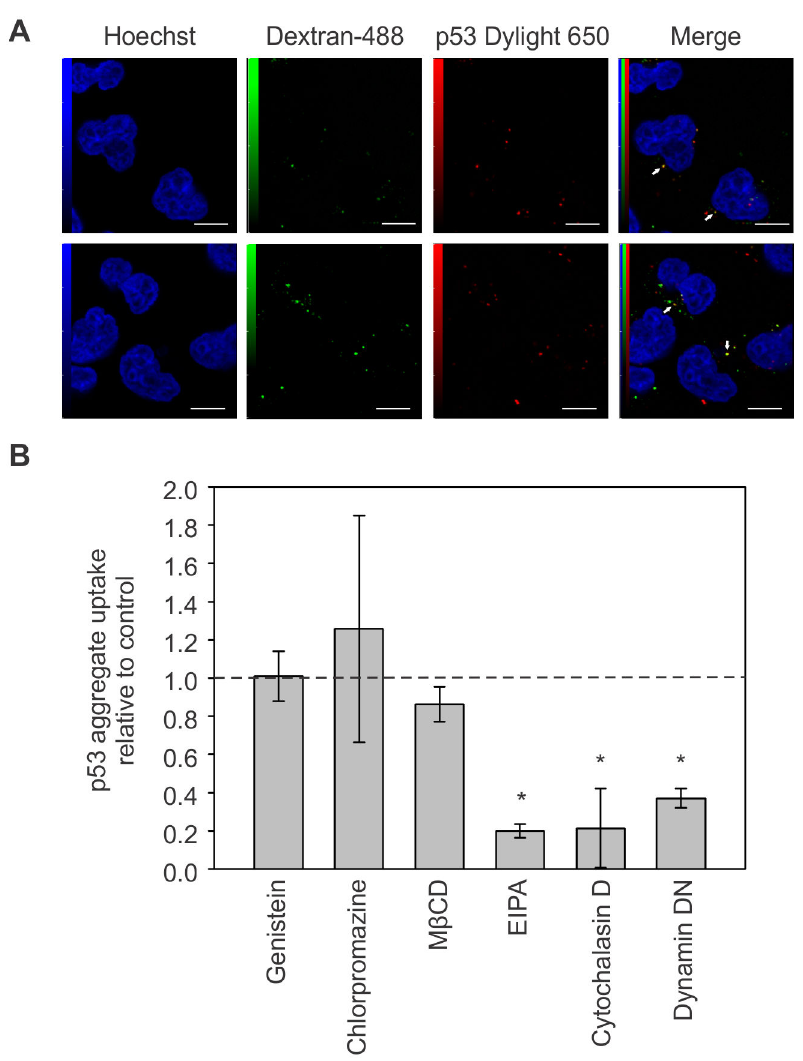
Figure 3. p53 aggregates are internalized via macropinocytosis. (A) HeLa cells were incubated with 1 µM DyLight 650- conjugated p53 aggregates and 50 µg/mL Dextran-488 overnight, and visualized by confocal microscopy. (B) HeLa cells were either treated with the indicated component or transfected with dominant-negative dynamin 24 h before incubation with 1 µM DyLight 650- conjugated p53 aggregates for 3h and analysed by flow cytometry. Mean value of 3 replicates is shown (*, p < 0,05); 50000 events were recorded per experiment. Scale bars: 10